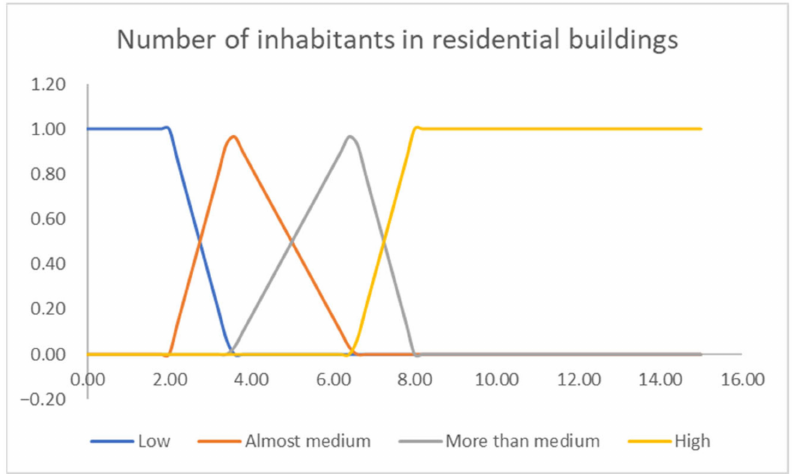
Figure 9. The new fuzzy partition given by 4 fuzzy